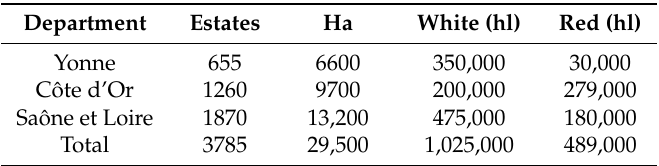
Table 1. Production per department in Burgundy in